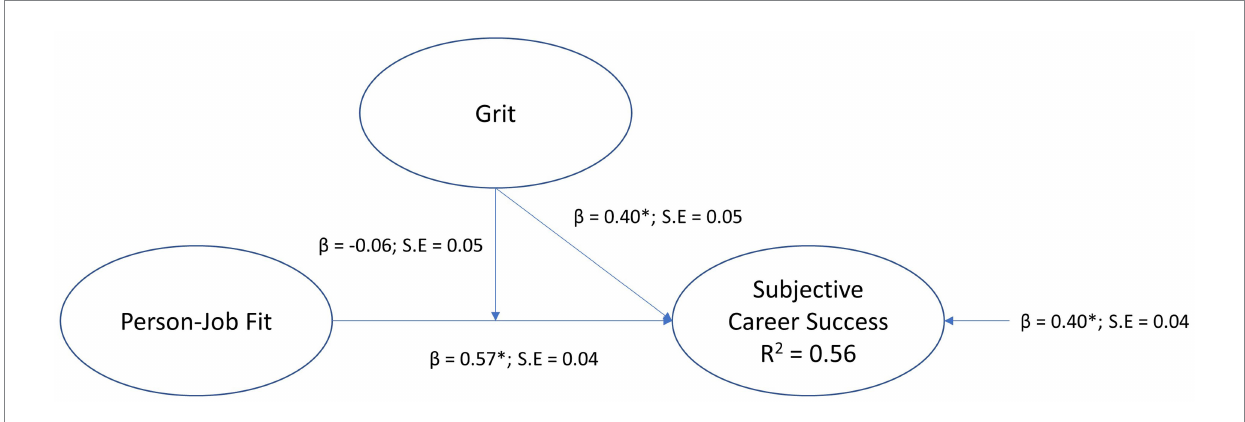
FIGURE 3 Moderation model for grit.